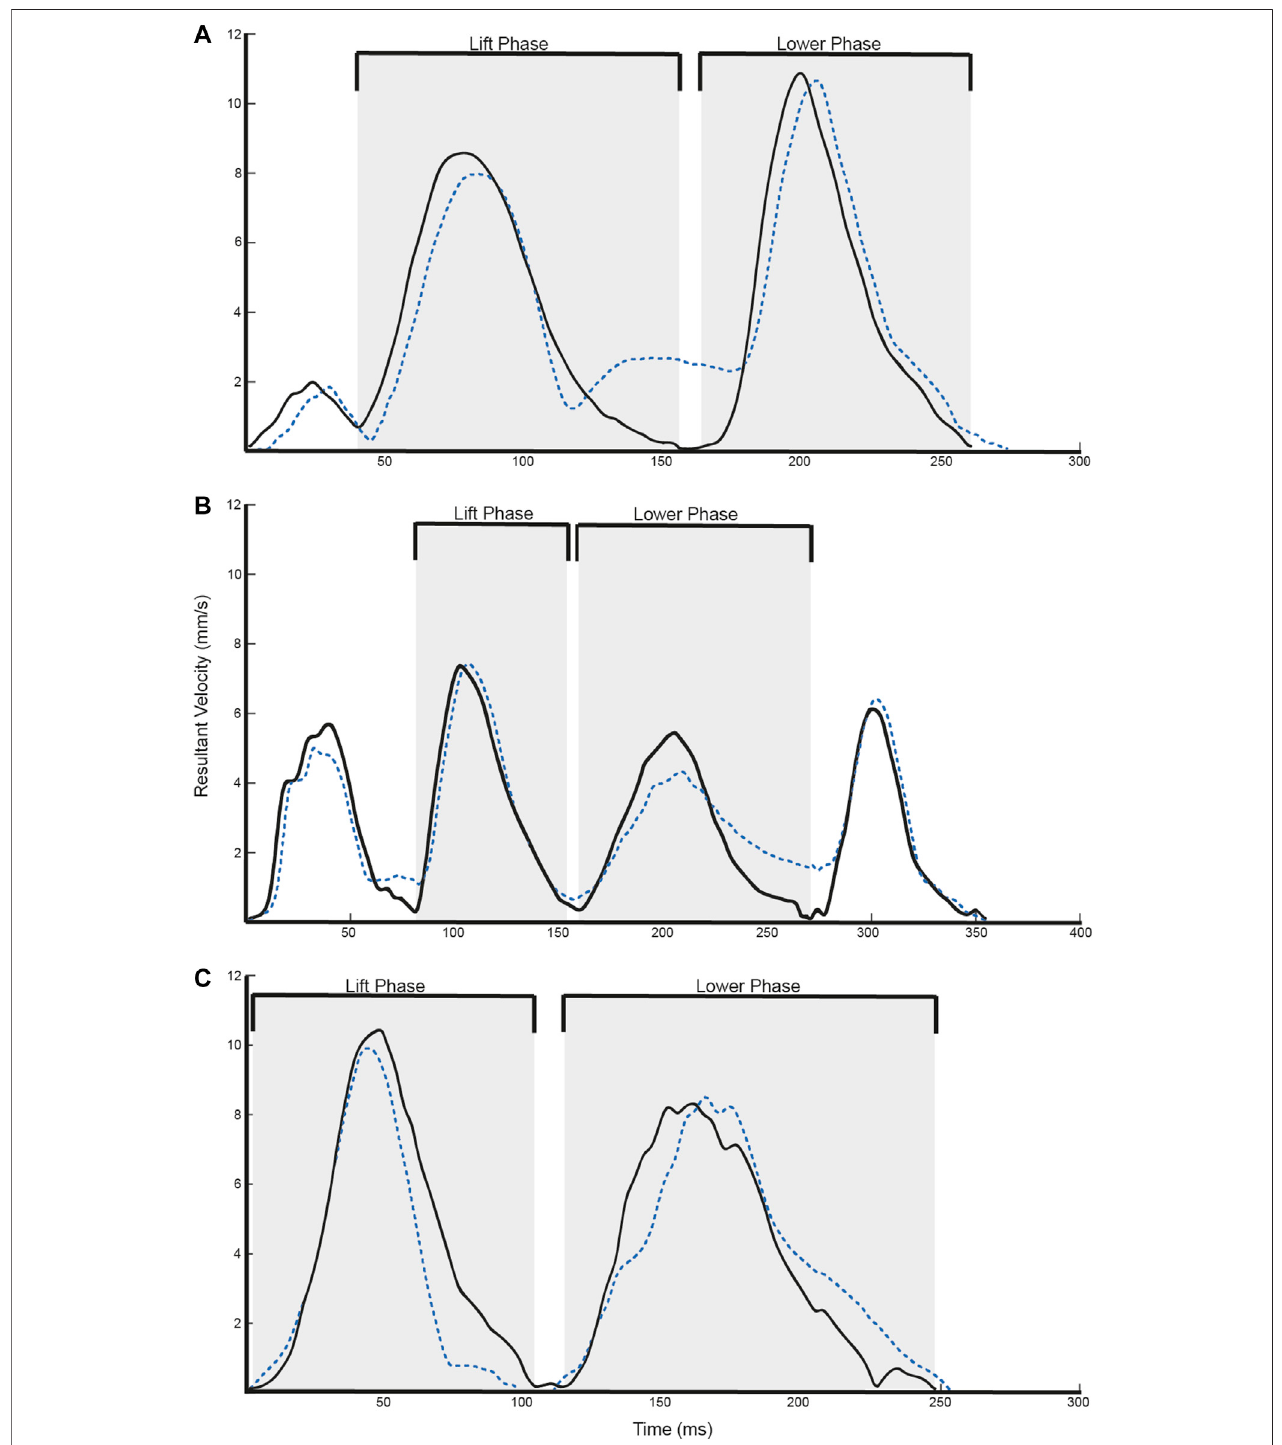
FIGURE2 | Representative velocity trajectories for the (A) Block, (B) Drink, and (C) Finger toNose tasks. Solid black lines referto Vicon data, whereas dotted blue lines refer to T ’ ena sensor data.